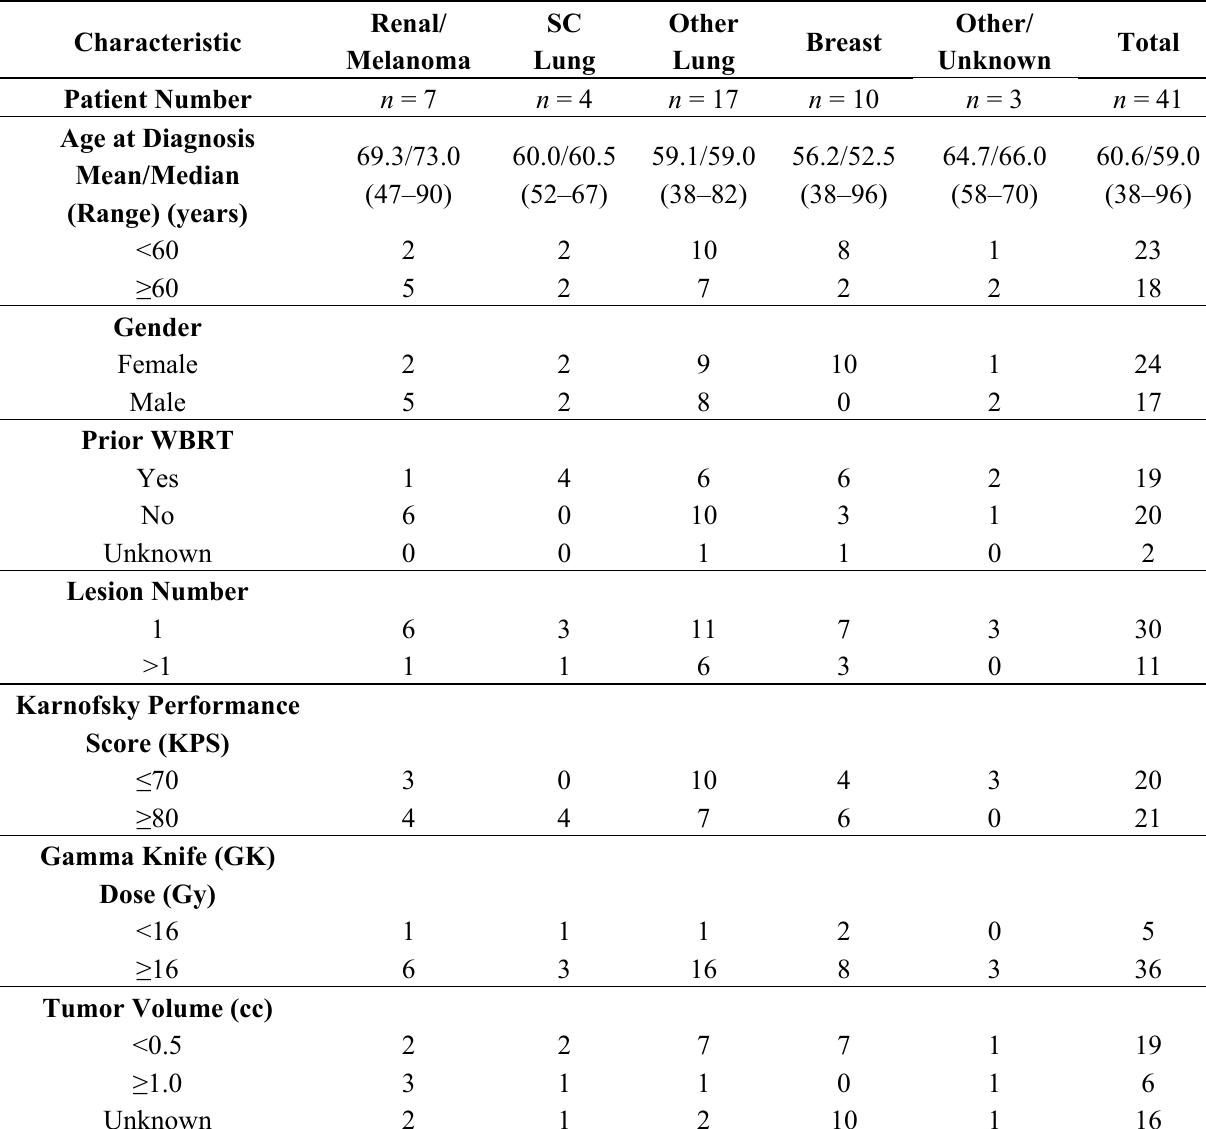
Table 1. Patient population baseline